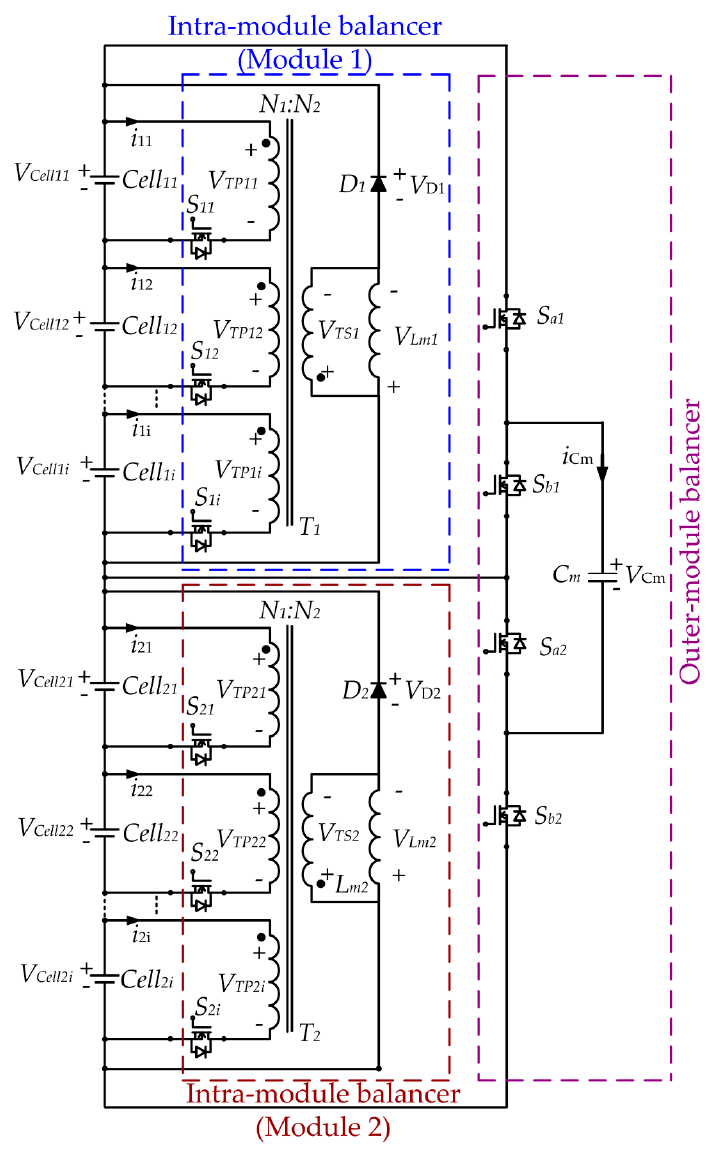
Figure 8. The proposed modular cell balancing circuit.